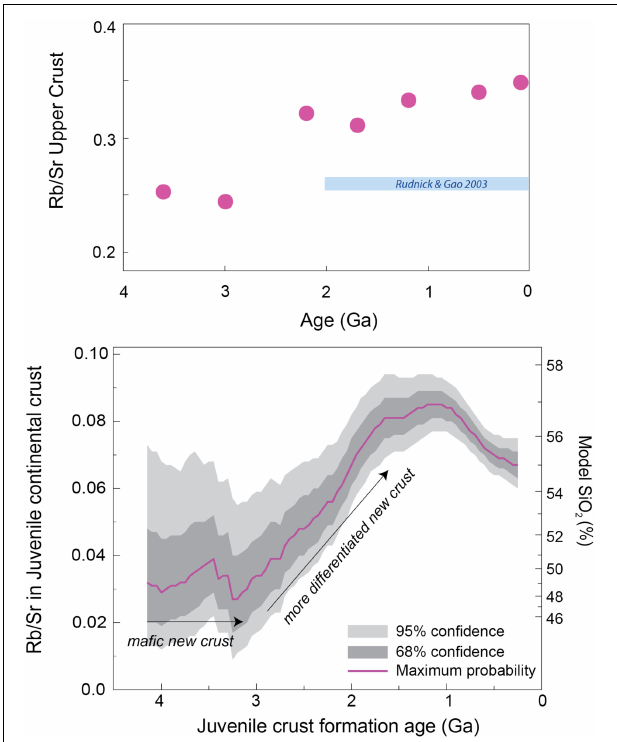
FIGURE 7 | Changes in the Rb/Sr ratios of the upper crust (map normalized) (Condie, 1993) and of juvenile continental crust (Dhuime et al., 2015) with time. The upper crust estimates of Rudnick and Gao (2003) is for average crust which has an age of ∼ 2 Ga. The estimates of SiO 2 contents of juvenile crust are taken from the co-variation of Rb/Sr and SiO 2 in magmatic rocks (Dhuime et al., 2015).